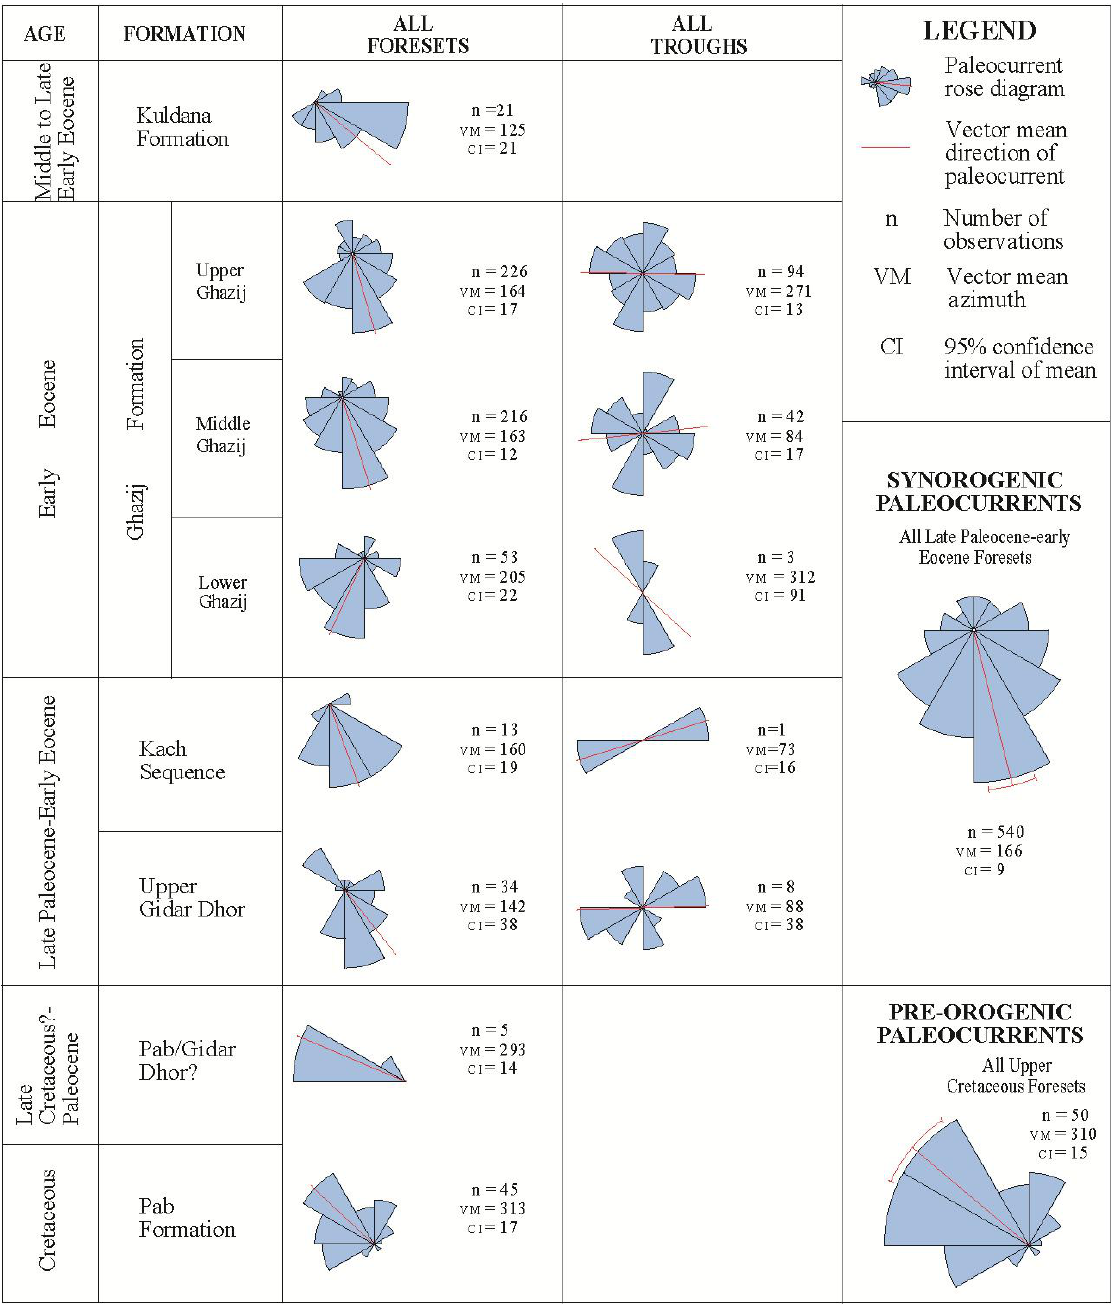
Figure 4. Summary of paleocurrents by formation shows dominant east-southeastward paleoflow during late Paleocene-early Eocene time. Prior to the Paleocene, the dominant paleoflow of sediments was to the west and northwest. This indicates a change in dispersal path of sediments and suggests a slope reversal of the Cretaceous shelf of the Indo-Pakistan subcontinent during late Paleocene-early Eocene time (see also Table S1 and Figures A5–A7).